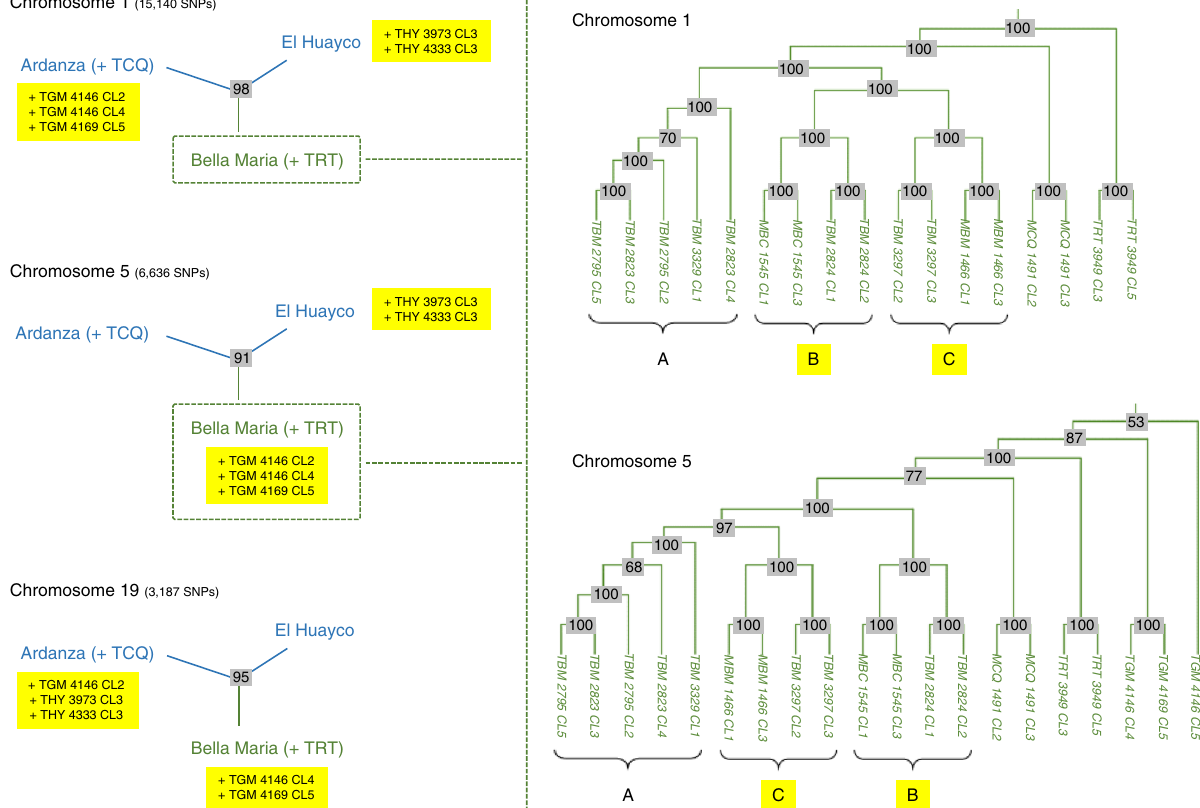
Fig. 5 Incongruent trees exemplify independent chromosomal ancestries among T. cruzi I clones. Within individual sample genomes from Cluster 1 and Cluster 2, different chromosomes present different phylogenetic ancestries. For example, when neighbor-joining trees are constructed separately for chromosomes 1, 5, and 19, Gerinoma clones (pre fi x TGM) cluster with those from Ardanza on chromosome 1. On chromosomes 5 and 19, they cluster with clones from Bella Maria. El Huayco clones THY 3973 CL3 and THY 4333 CL3 also join the Ardanza clade on chromosome 19. Within Cluster 1 (right panel), chromosome 1 presents a monophyletic clade composed of MBC_1545 + TBM_2824 (labeled B) and MBM_1466 + TBM_3297 clones (C). TBM_2795 + TBM_2823 + TBM_3329 clones (A) form an outgroup. These clades rearrange on chromosome 5, where A changes places with C. The A + B monophylum occurs again on chromosome 19, while the B + C group makes appearances on chromosomes 9 and 16, etc. Discrepant phylogenies such as those highlighted here occur in various chromosomal comparisons throughout the genome. Nodes are labeled in gray with support values from 100 bootstrap replicates. Green denotes the Cluster 1 clade. Blue denotes Cluster 2. Yellow highlights unstable phylogenetic positions among different chromosomes. Branch lengths are not proportional to genetic